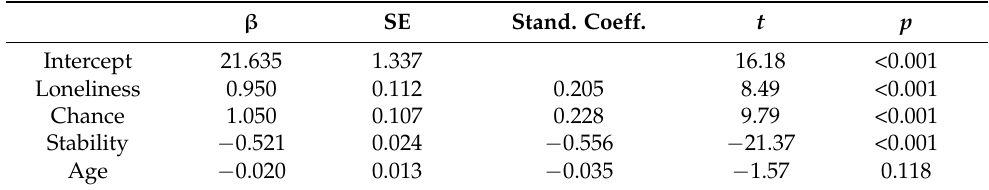
Table 4. Multiple regression analysis (beta weights, standard errors, standardized coefficients, t , and p -values) of the contributions of pandemic-associated concerns and Age to psychological distress (HADS). β SE Stand. Coeff. t p Intercept 21.635 1.337 16.18 <0.001 Loneliness 0.950 0.112 0.205 8.49 <0.001 Chance 1.050 0.107 0.228 9.79 <0.001 Stability − 0.521 0.024 − 0.556 − 21.37 <0.001 Age − 0.020 0.013 − 0.035 − 1.57